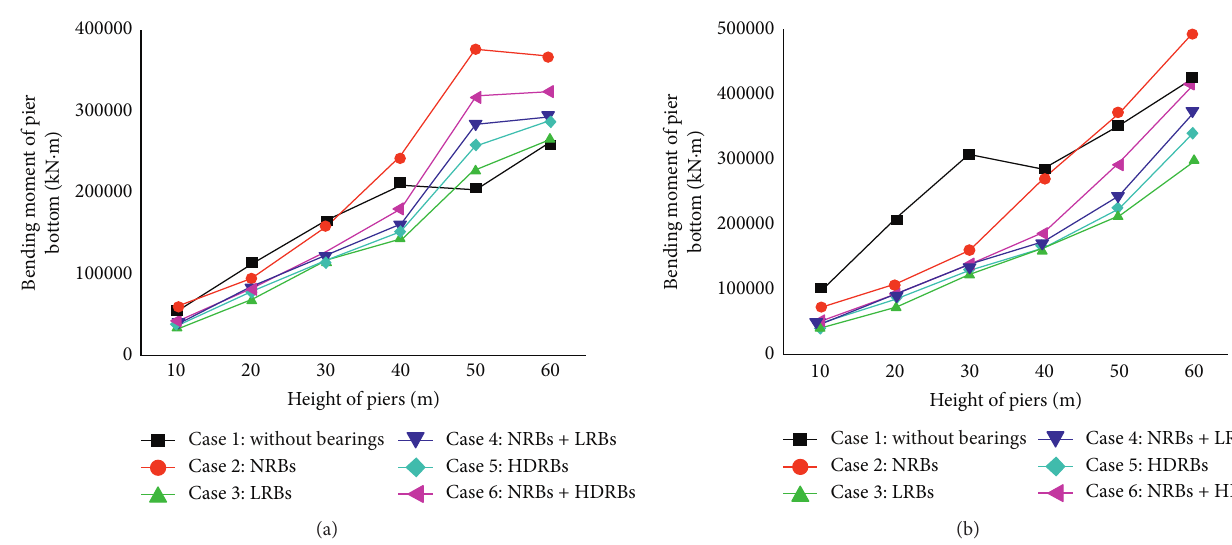
Figure 14: Bottom bending moments of the piers with the change of pier height in different cases: (a) longitudinal; (b)